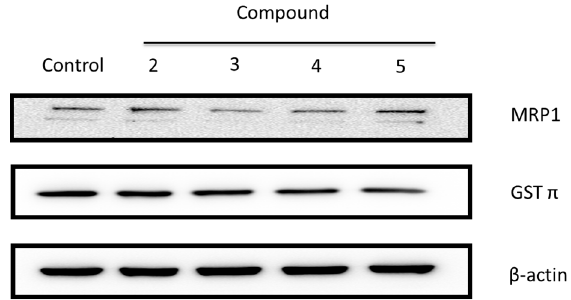
Figure 5. Effects of 6-shogaol ( 2 ), 10-shogaol ( 3 ), 6-gingerol ( 4 ), and 10-gingerol ( 5 ) (100 μ M) on MRP1 and GST π in PC3R at 24 h time point. Results are representative of three experiments.